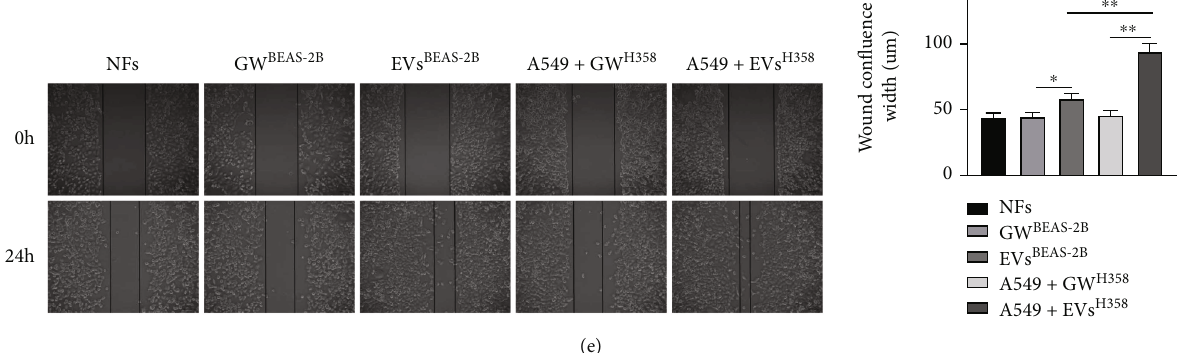
Figure 2: T-EVs promoted the invasion and migration of LC cells through CAFs activation. A549 cells were cultured in EVS-treated NFCM for 24 hours. (a) Cell viability was detected by MTT assay; (b) cell proliferation was detected by CCK-8 assay; (c, d) transwell assay was used to detect cell invasion and migration; (e) the scratch test was used to detect cell migration. Cell experiment was repeated three times. One- way ANOVA was used for data comparison among multiple groups, and Tukey ’ s test was used for the post hoc test. ∗ P < 0 : 05 , ∗∗ P < 0 : 01 .